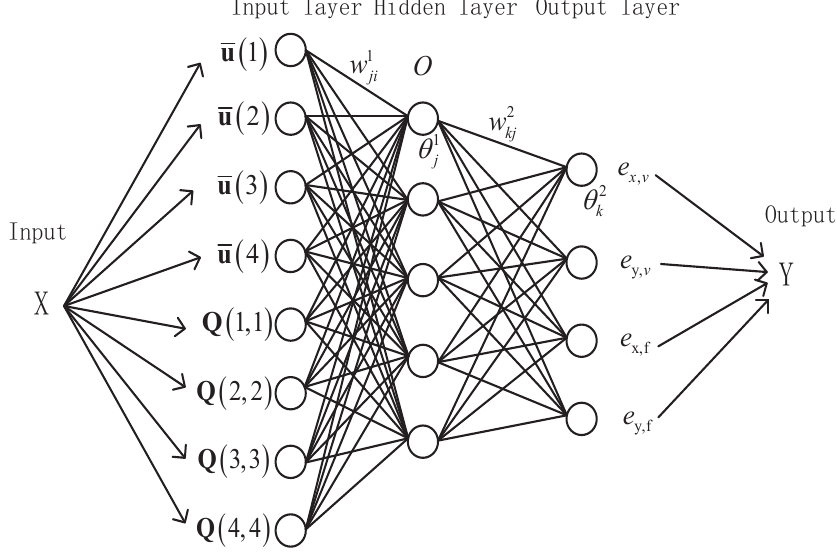
Figure 6. The neural network